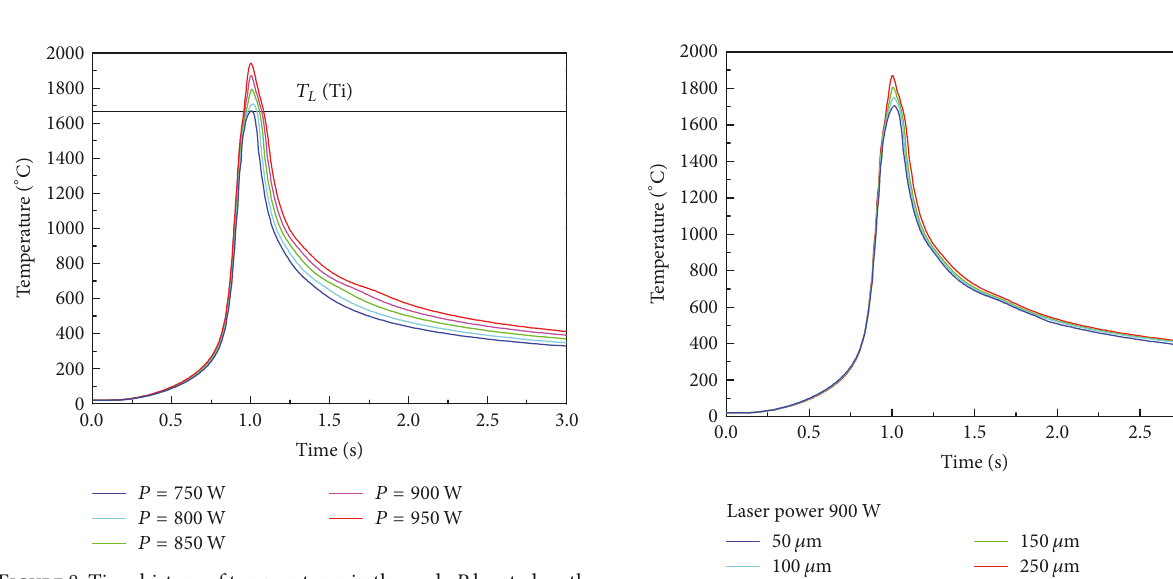
at the interface of welded Al-Ti plates. The dependence of temperatures on the distance from the weld centre for different laser offsets and the laser power of 850 W and 900 W, respectively, is shown in Figure 10. The influence of laser power on the temperature distribution along the line perpendicular to the weld centre is documented in Figure